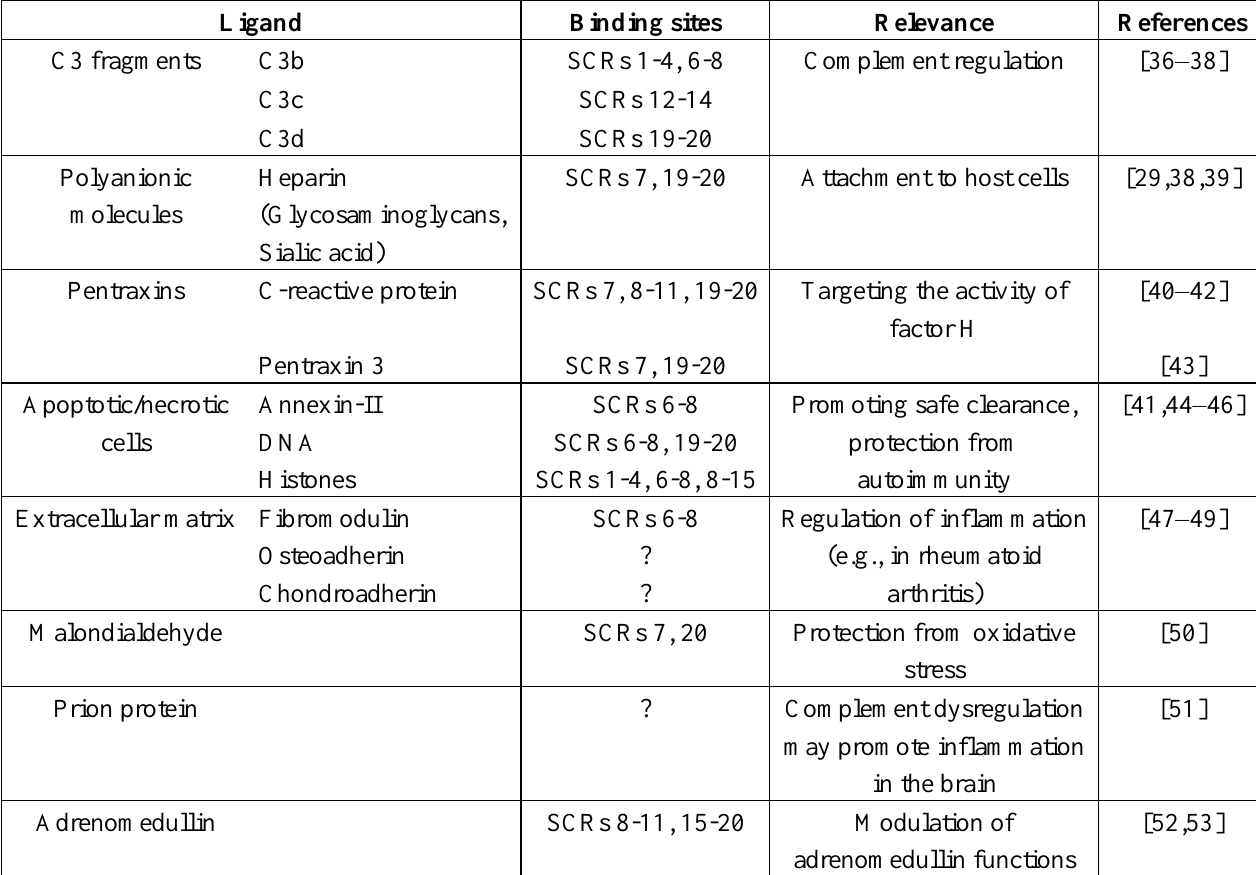
Table 1. Factor H ligands, binding sites and potential relevance of the